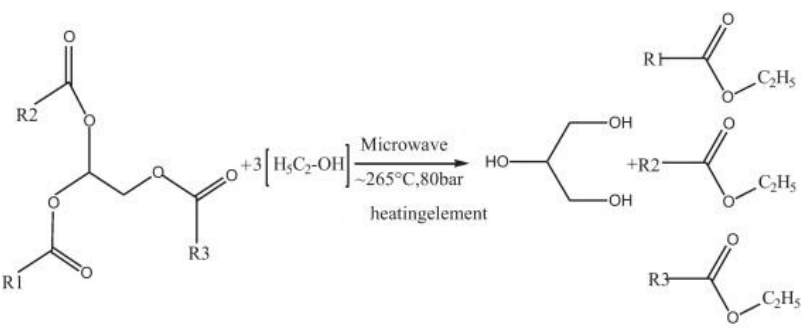
Figure 10. The microwave-mediated transesterification of algal biomass under supercritical ethanol conditions to yield ethyl ester.